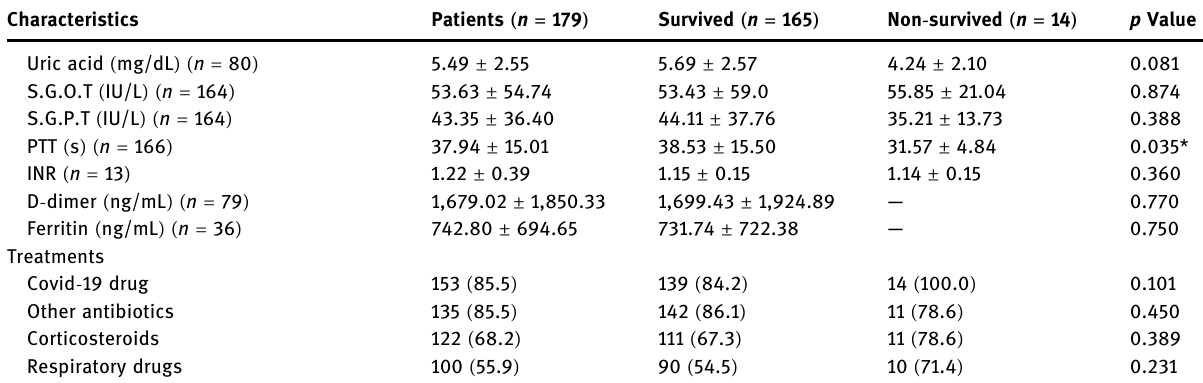
Other antibiotics